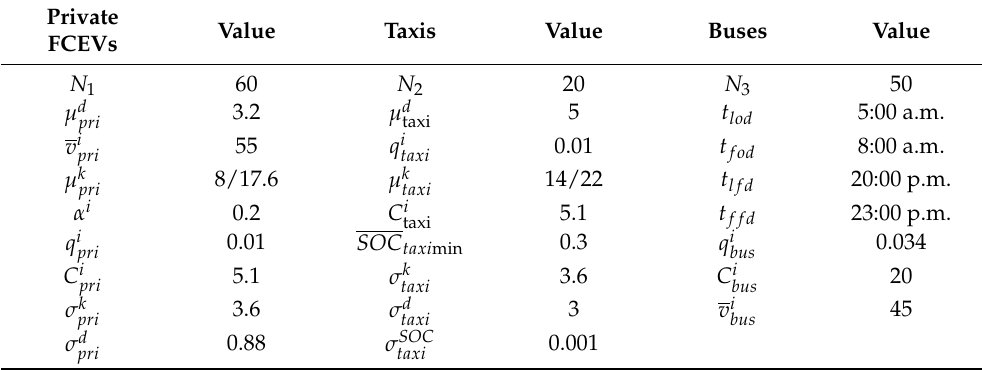
Table 1. Parameters for hydrogen demand